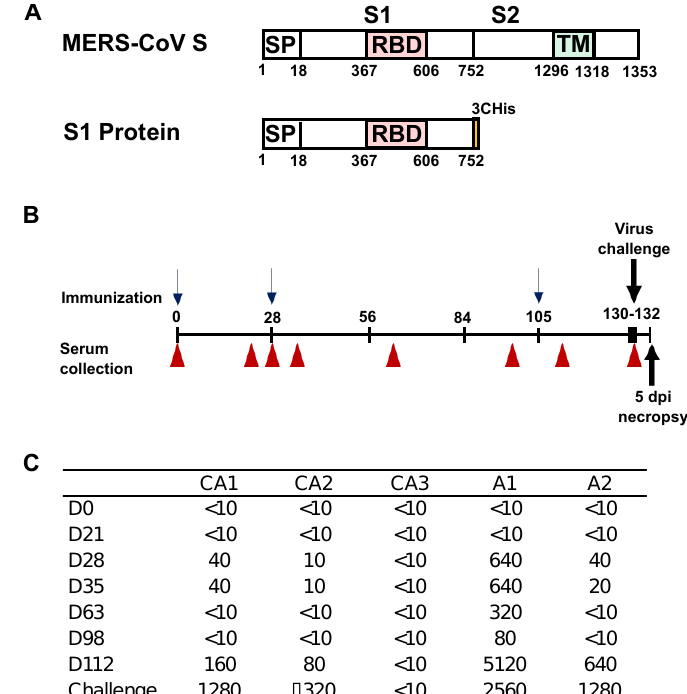
Figure 1. Vaccine immunogens and neutralizing antibody responses. ( A ) Schematic representation of the full MERS-CoV spike protein (top) and the S1 subunit used as antigen for vaccination (bottom). ( B ) Schematic overview of the immunization timeline with the immunization (blue arrows), serum sampling (red triangle), and challenge and euthanasia (black arrows) time points indicated. ( C ) Neutralizing antibody titers in dromedary camels and alpacas vaccinated with adjuvanted MERS-CoV S1 as determined by PRNT (90% neutralization).